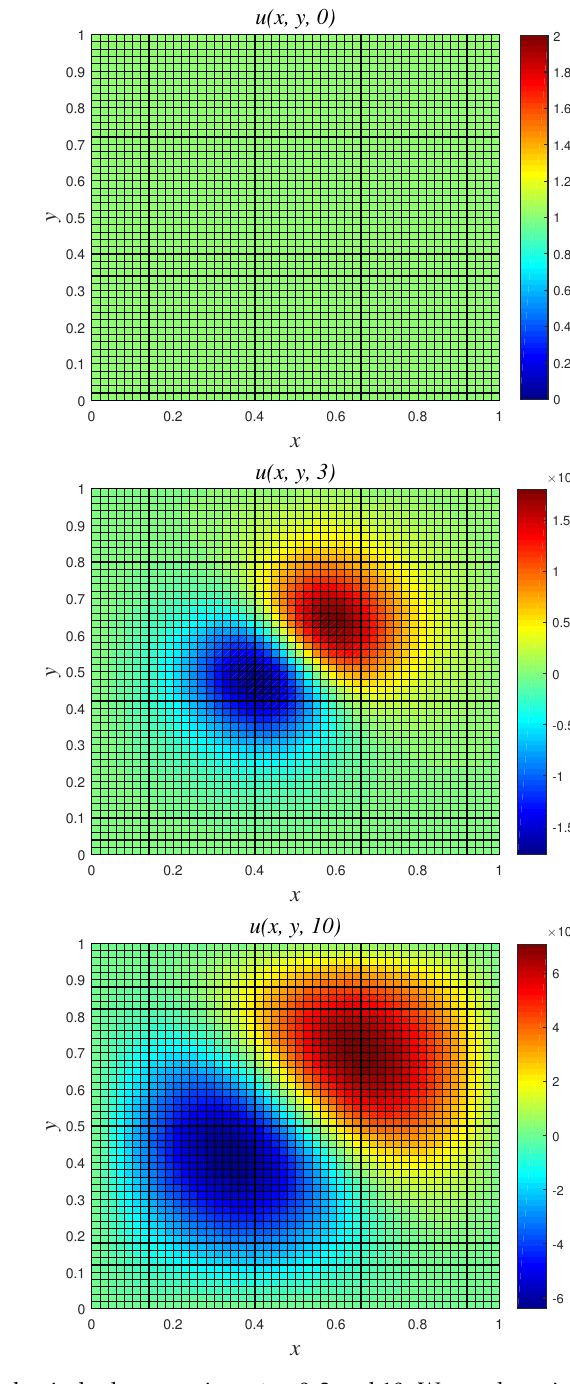
Figure 8. 3D plots of numerical solution vs. x vs. y using classical scheme at times t = 0,3 and 10. We used spatial step sizes h x = h y = 0.02 and time step k =